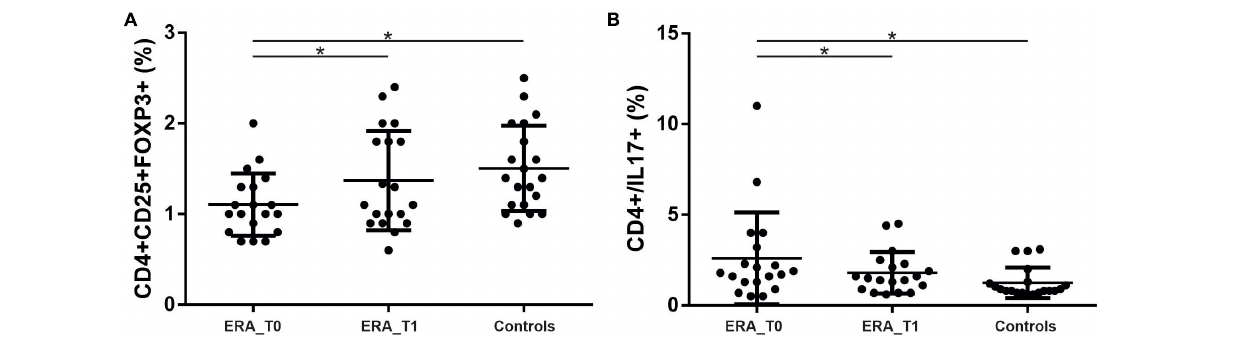
FIGURE 3 | Percentage of Th17 and Treg cells in the peripheral blood of patients with rheumatoid arthritis at T0 and T1. (A) Significant increase in the percentage of Th17 in RA patients compared to controls and a reduction in the percentage of Th17 cells at T1 compared to T0. (B) Significant increase in the percentage of Treg cells in the control group compared to RA and a significant increase in Treg cells in RA patients at T1 compared to T0. * significant difference at alpha value